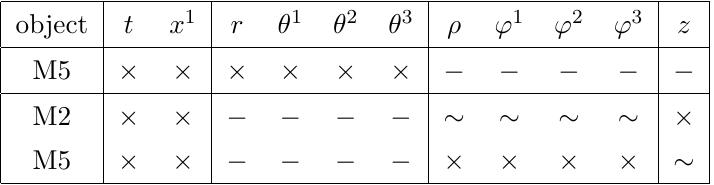
-BPS brane system underlying the intersection of M2–M5 branes intersecting M5 Table 1 . The 1 4 branes. The “ ∼ ” denotes smearing along the corresponding